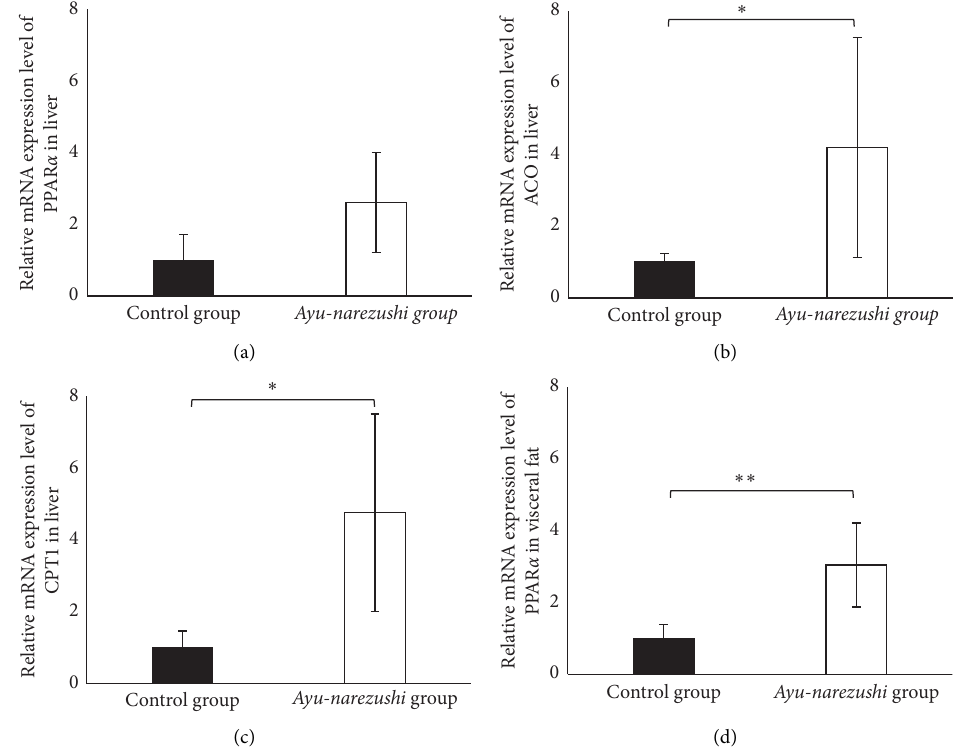
Figure 4: PPAR α (a), ACO (b), and CPT1 (c) mRNA levels in liver and PPAR α (d) mRNA levels in visceral fat. Each tissue was isolated at 24 weeks of age. The mRNA levels were determined by real-time PCR, normalized to glyceraldehyde-3-phosphate dehydrogenase. The data represent the mean ± standard deviation of 5 animals. ∗ Significantly different from the control group with ∗ P < 0.05; ∗∗ P < 0.01. PPAR, peroxisome proliferator-activated receptor; ACO, acyl-CoA oxidase; and CPT1, carnitine-palmitoyl